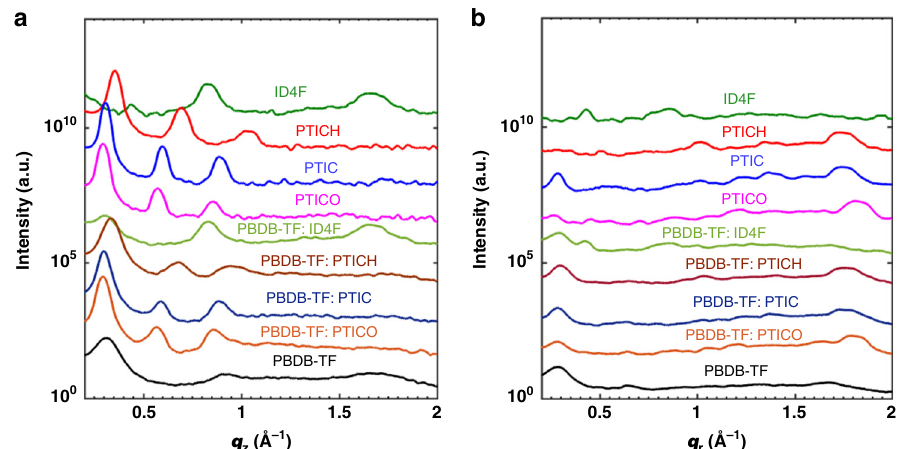
Fig. 4 Morphologies of neat and blend fi lms. The GIWAXS intensity pro fi les along the out-of-plane ( a ) and in-plane ( b ) directions